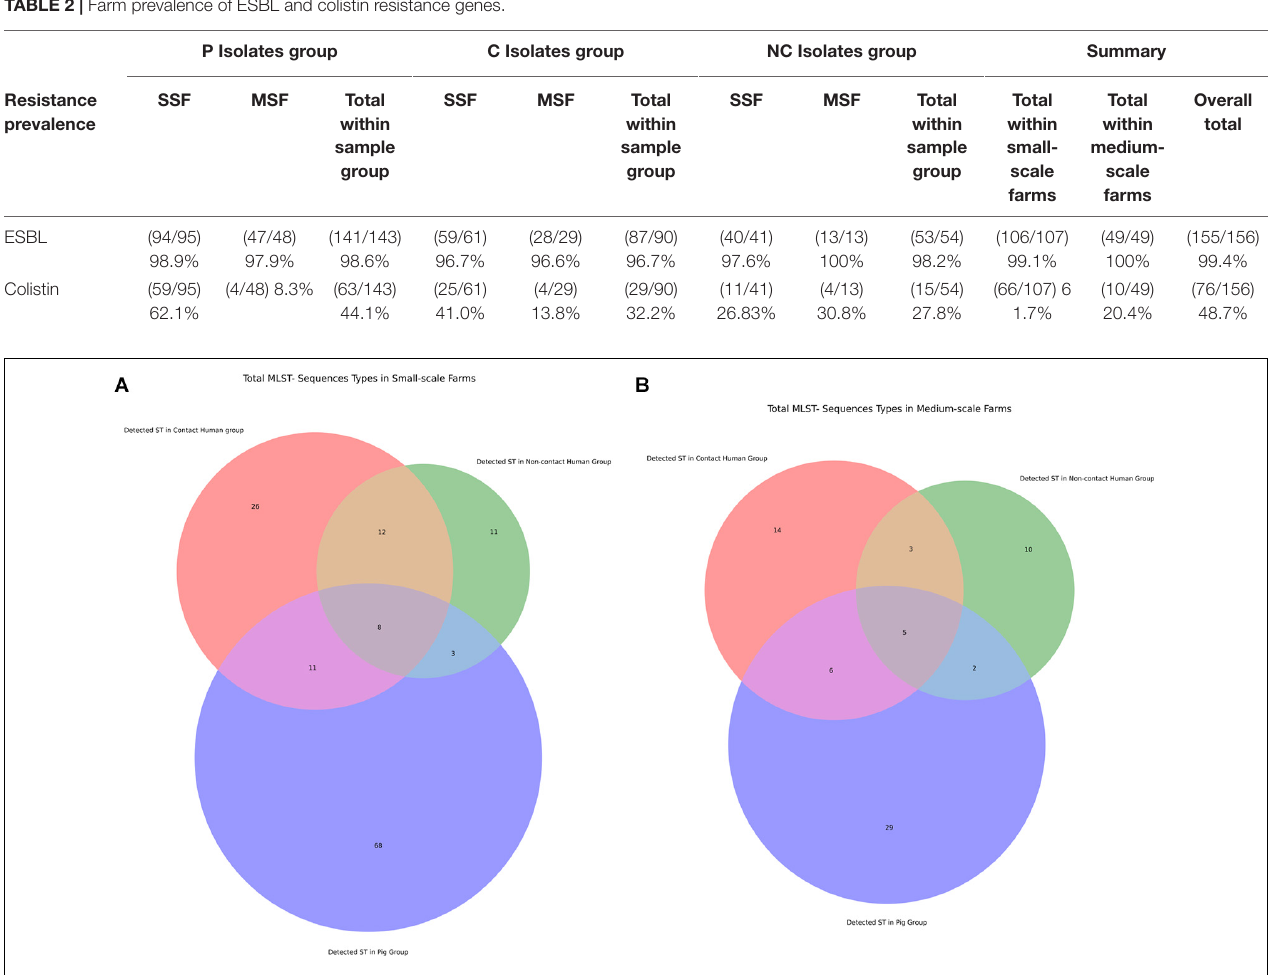
FIGURE 5 | Venn diagram of Multi Locus Sequence Types shared between different investigation groups. (A) Comparison of STs in small-scale farms. (B) Comparison of total STs genes in medium-scale farms.